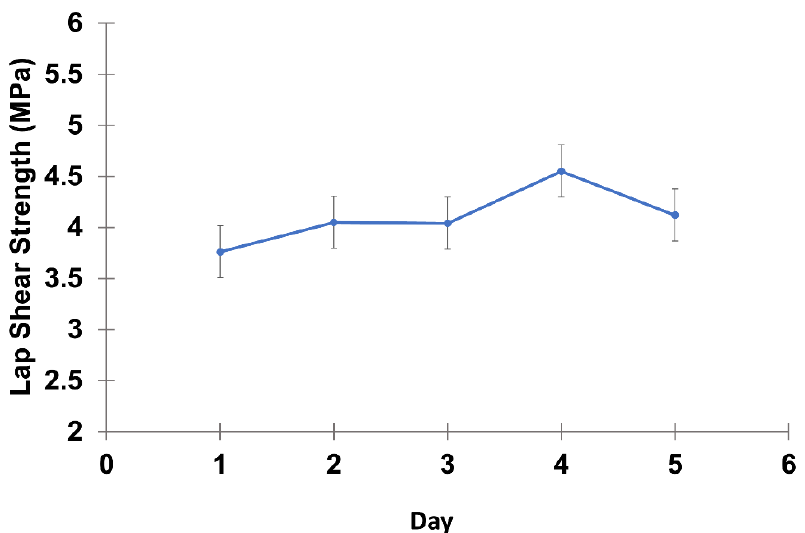
Figure 1. Lap shear test versus curing exposure period of lignin-based PU adhesive formulated with NCO/OH = 1.1 (PU 1.1).